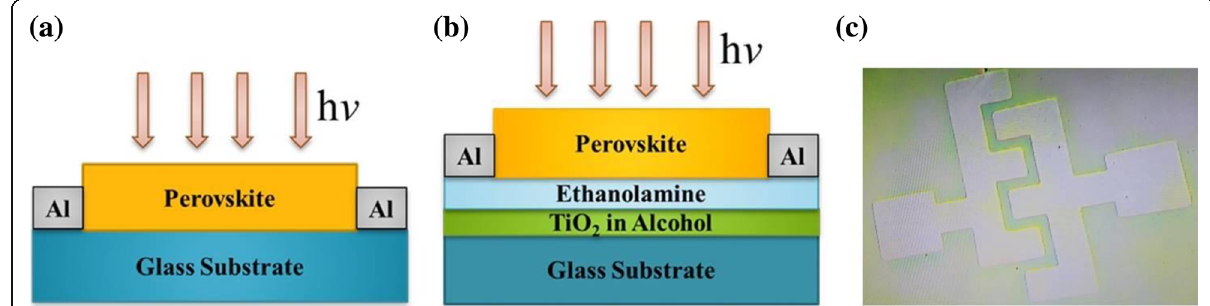
Fig. 1 a The single-layer device. b The trilayer device. c Optical image of trilayer